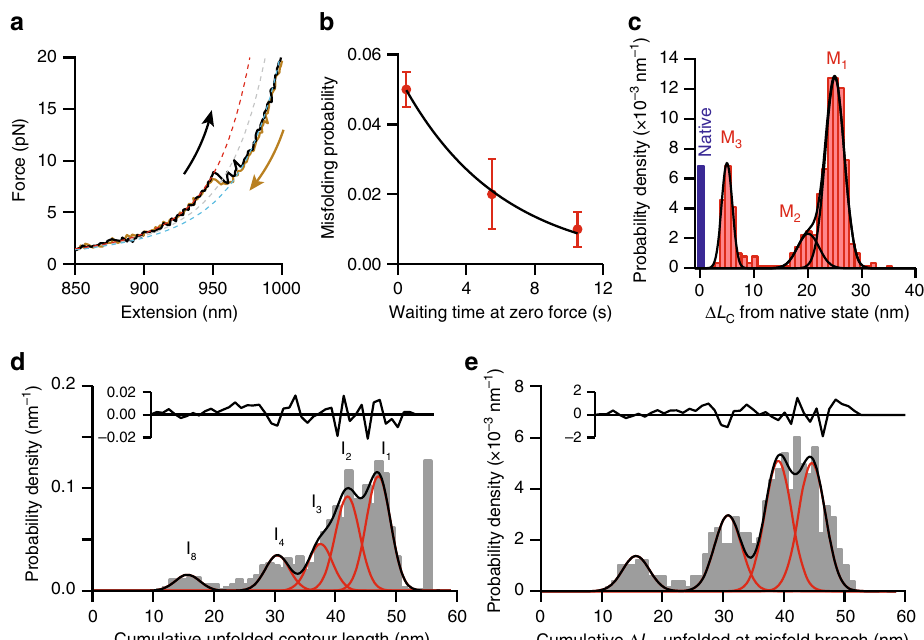
Fig. 6 SOD1 misfolding. a Unfolding (black) and refolding (brown) FECs of a SOD1 monomer showing a non-native total contour length change. Dashed lines: WLC fi ts to the misfolded (red), intermediate (gray), and unfolded (cyan) states. b The fraction of curves showing misfolding decreases exponentially with the waiting time at zero force between successive pulls, revealing a misfolded-state lifetime of 6 s. c The distribution of the contour length remaining unfolded in the misfolded state, as measured from all FECs exhibiting misfolding, contains three peaks re fl ecting at least three distinct misfolded structures. d The distribution of cumulative contour length of unfolded protein at each intermediate state observed in FECs exhibiting misfolding, measured with respect to the length of the native state, shows peaks (red) at many of the same positions seen in native unfolding and refolding FECs. The position of the unfolded state is shown as a single bar at 54.7 nm. e The distribution of the cumulative unfolded contour lengths of the intermediate states at which misfolding branched from the native folding pathways, measured with respect to the length of the native state